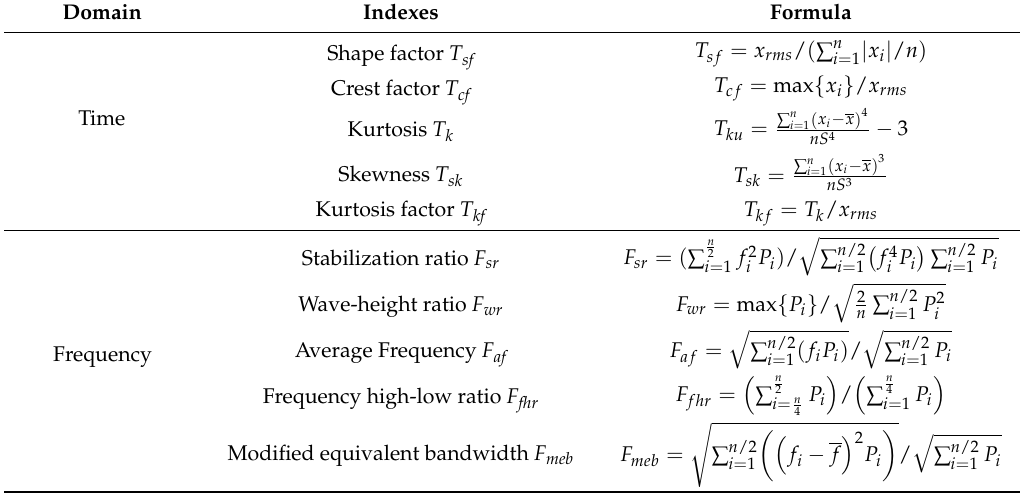
Table 1. Ten time domain and frequency domain dimensionless statistical parameters 1 .